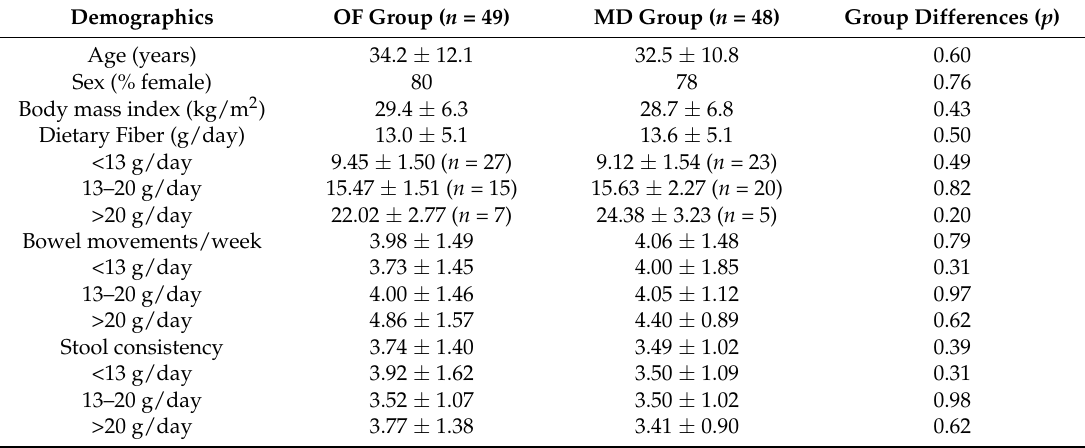
Table 1. Baseline demographics (means and standard deviations) of the adult participants assigned to the oligofructose (OF) group or maltodextrin (MD) group (placebo).